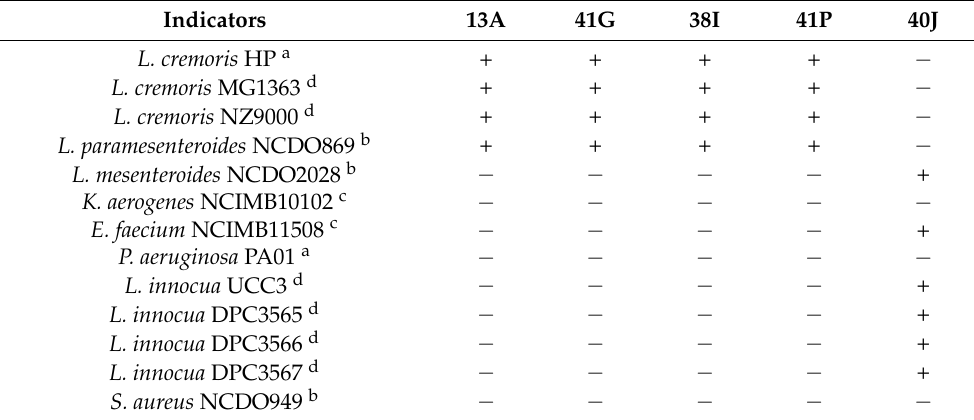
Table 2. Well diffusion assay of CFS (pH neutralized to 6–7, catalase added to eliminate the effect of H 2 O 2 ) of L. plantarum 13A, 41G, 38I and 41P and P. acidilactici 40J against a range of indicators. Presence of zone of inhibition was presented as ‘+’ and absence of zone of inhibition was presented as ‘ −